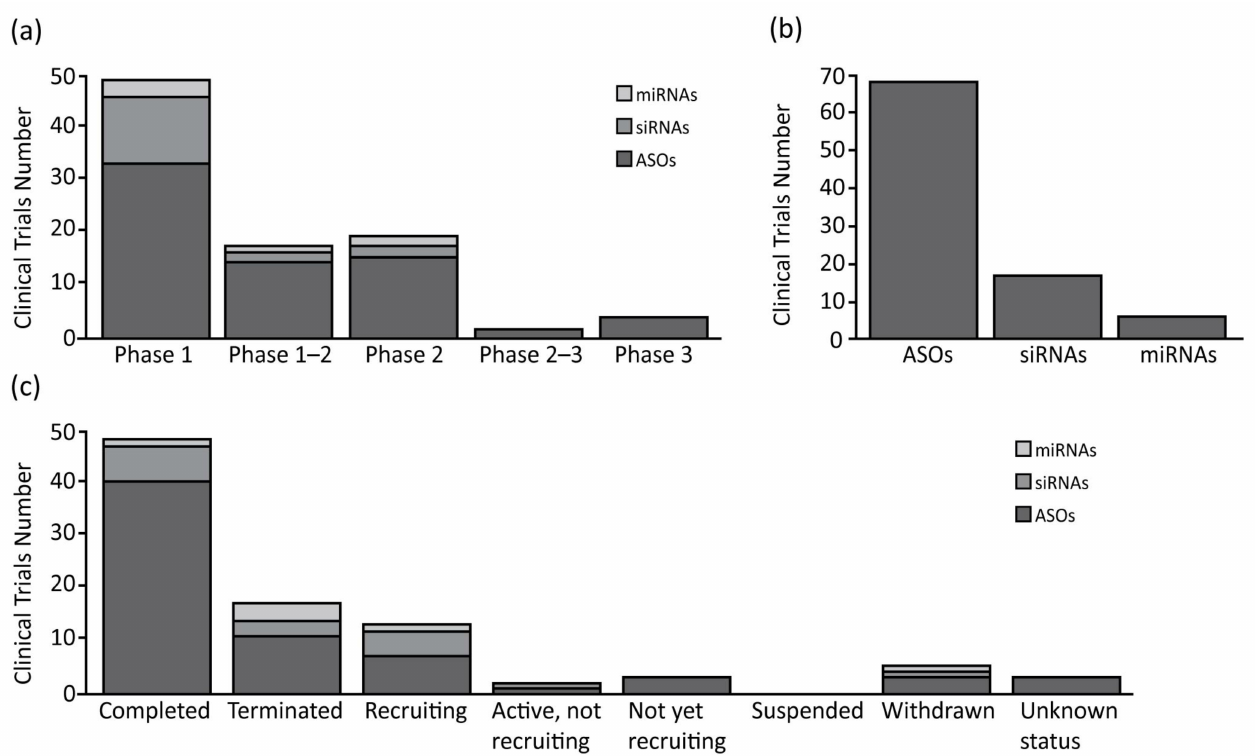
Figure 1. Summary of clinical trials therapies using oligonucleotide in oncology. ( a ) Antisense oligonucleotides (ASOs), small interfering RNAs (siRNAs) and microRNAs (miRNAs) number of clinical trials divided for clinical phases; ( b ) Total clinical trials number for each class of oligonu- cleotide analyzed; ( c ) ASOs, siRNAs and miRNAs number of clinical trials divided for clinical status